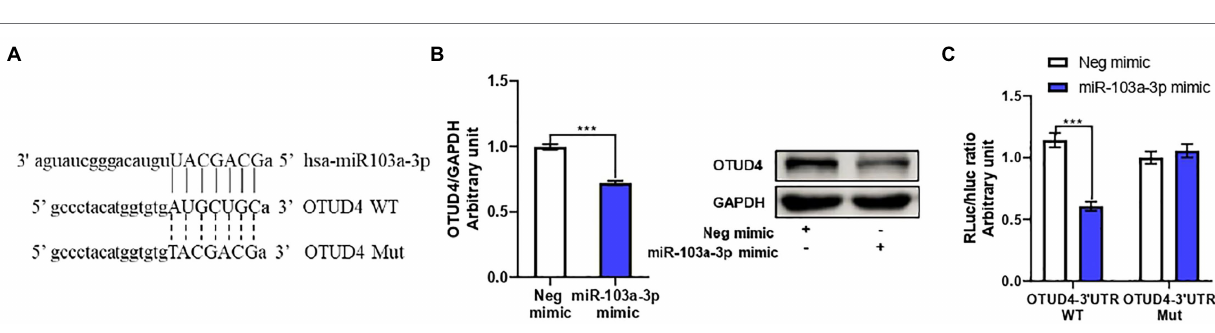
FIGURE 4 | OTU deubiquitinase 4 (OTUD4) is a target gene of miR-103a-3p. A549 cells were transfected with miR-103a-3p or co-transfected with miR-103a-3p and luciferase reporter plasmid. Total RNA, protein, and lysates of cells were harvested at 48 h post transfection for qRT-PCR, Western blot, and Luciferase reporter assays. (A) The putative binding sites in wide-type (WT) and corresponding mutant (MUT) sites of miR-103a-3p seed sequence on the 3 ′ -untranslated region (3 ′ UTR) of OTUD4. (B) miR-103a-3p decreases both mRNA and protein levels of OTUD4. (C) The luciferase activity is decreased in the group co-transfected of miR-103a- 3p mimic and OTUD4-3 ′ UTR-WT plasmid, but not of OTUD4-3 ′ UTR-Mut plasmid. Data are presented as mean ± SD. Error bars indicate SD ( n ≥ 3). *** p <